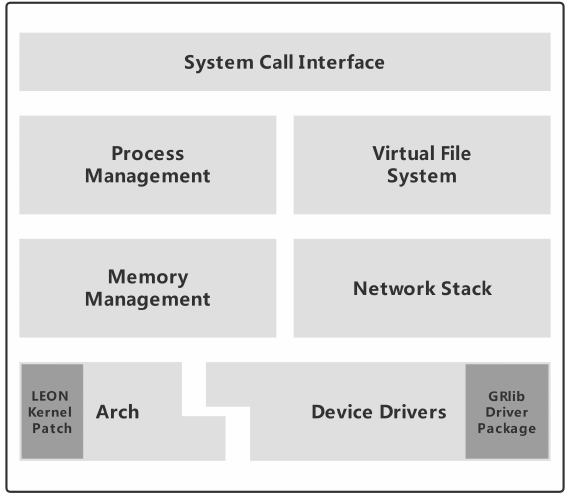
Figure 2. Linux kernel